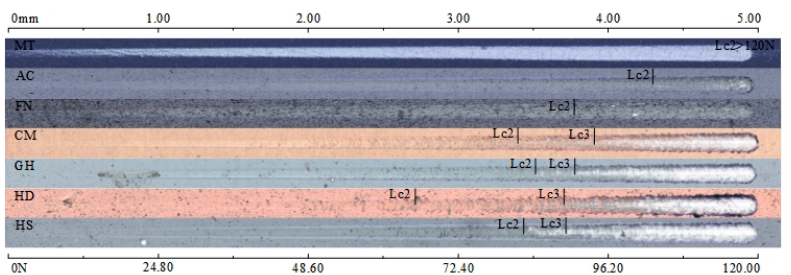
Figure 11. Scratch morphology of each coating surface.